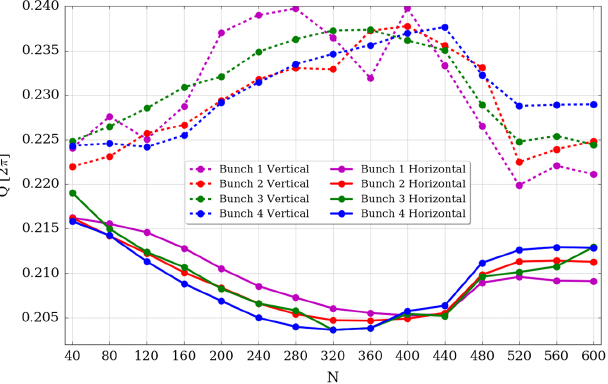
FIG. 19. Horizontal betatron tune measurements at the KARA light source under the operation of the CLIC superconducting wiggler. The case for the field of the wiggler at 2.9 T is shown in red, while the zero field case is shown in blue. The error bars are one standard deviation from the mean value of the measurements.